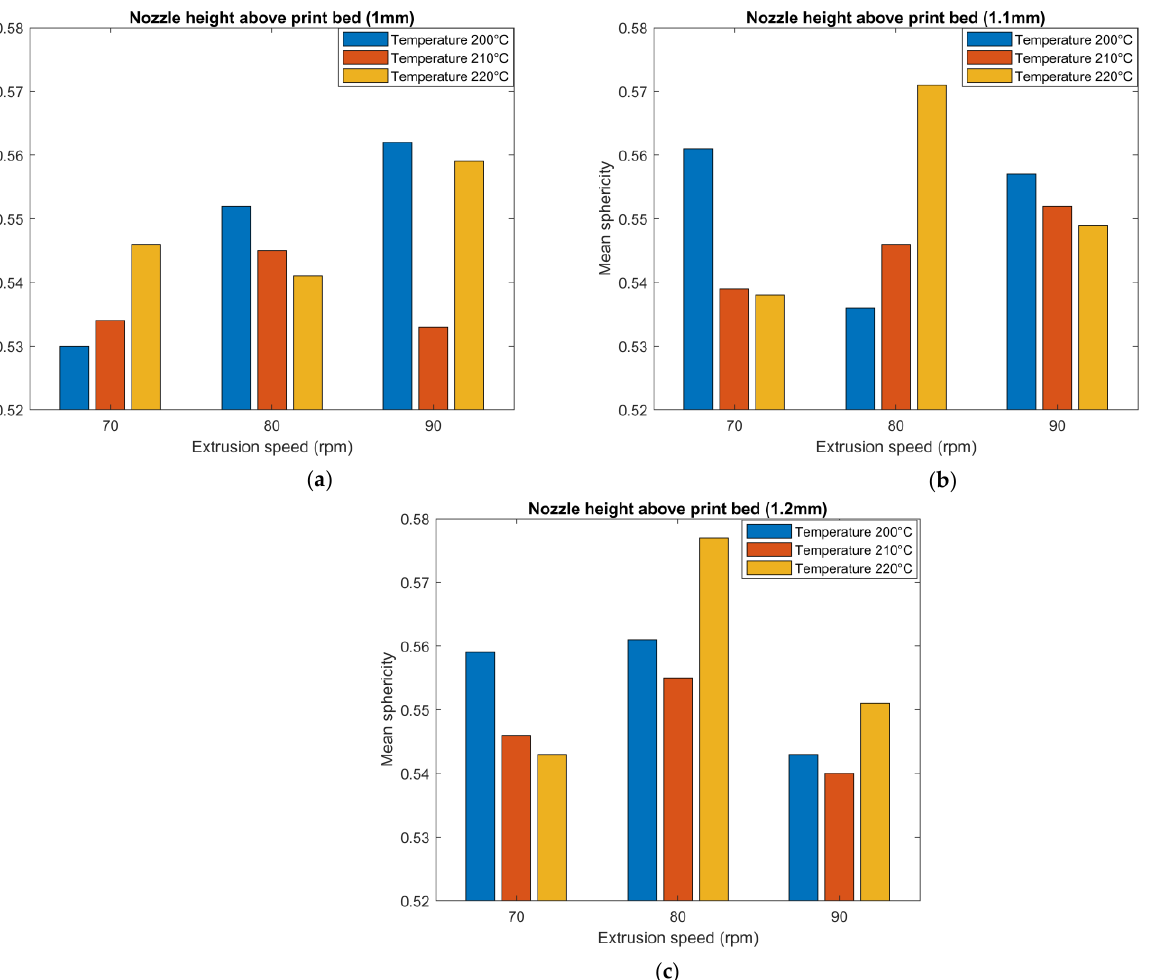
Figure 13. Effect of printing process parameters on mean void sphericity for: ( a ) nozzle height (1 mm); ( b ) nozzle height (1.1 mm); ( c ) nozzle height (1.2 mm).